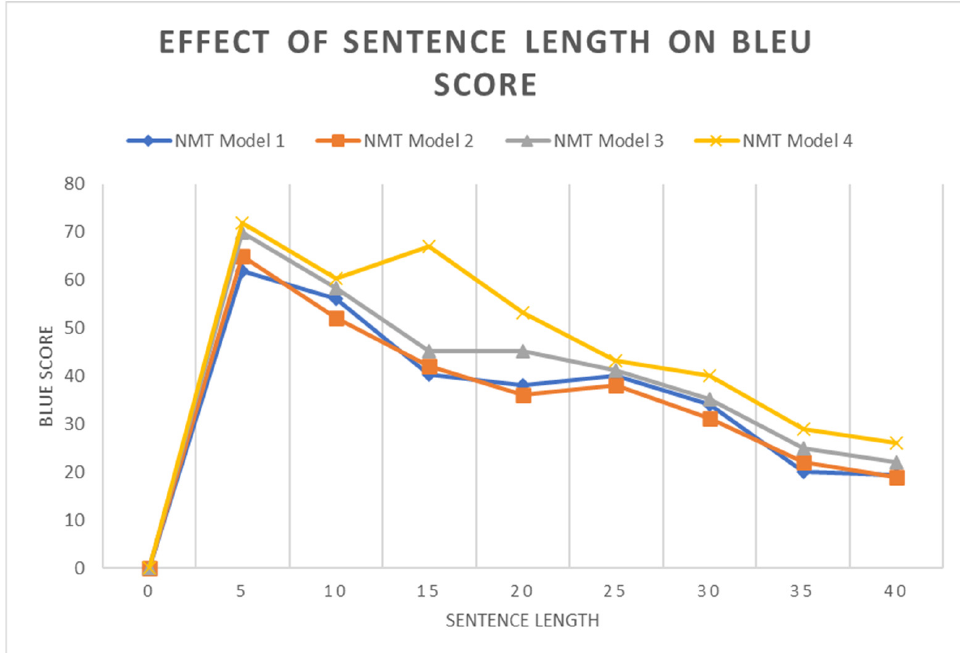
Figure 9. BLEU score of different sentences.